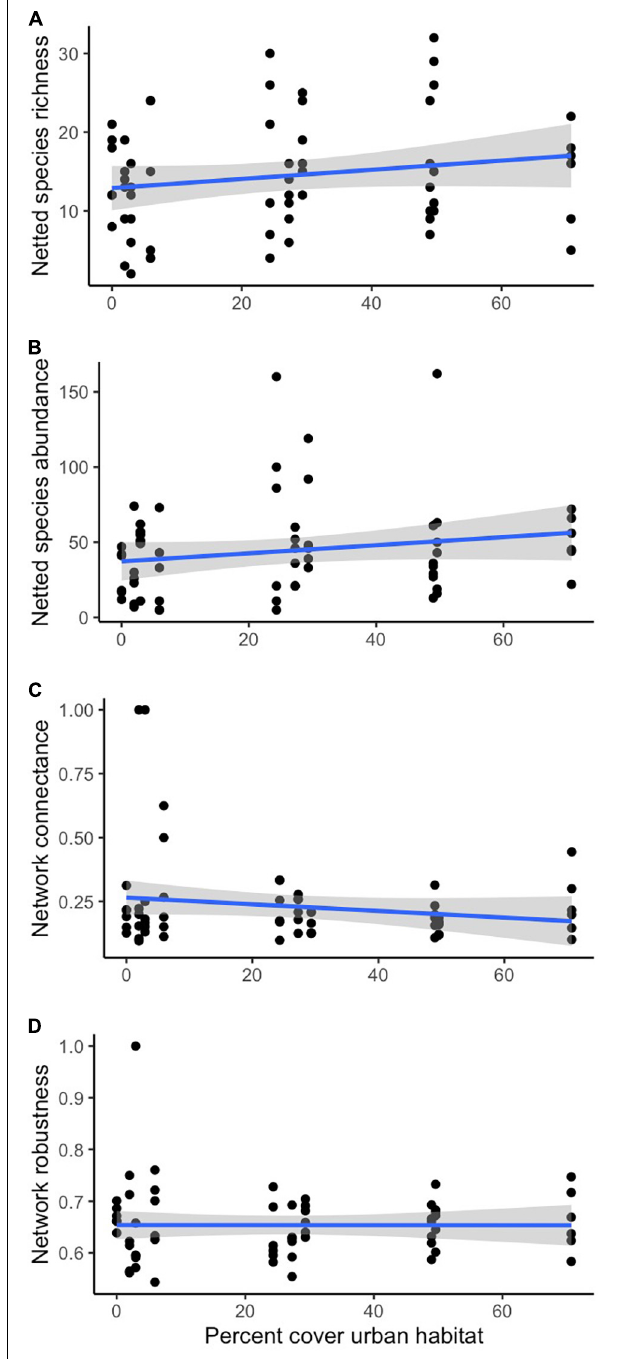
FIGURE 3 | Linear regressions for the significant relationships between percent urban cover and netted species richness (A) , netted species abundance (B) , network connectance (C) , and network robustness (D) .